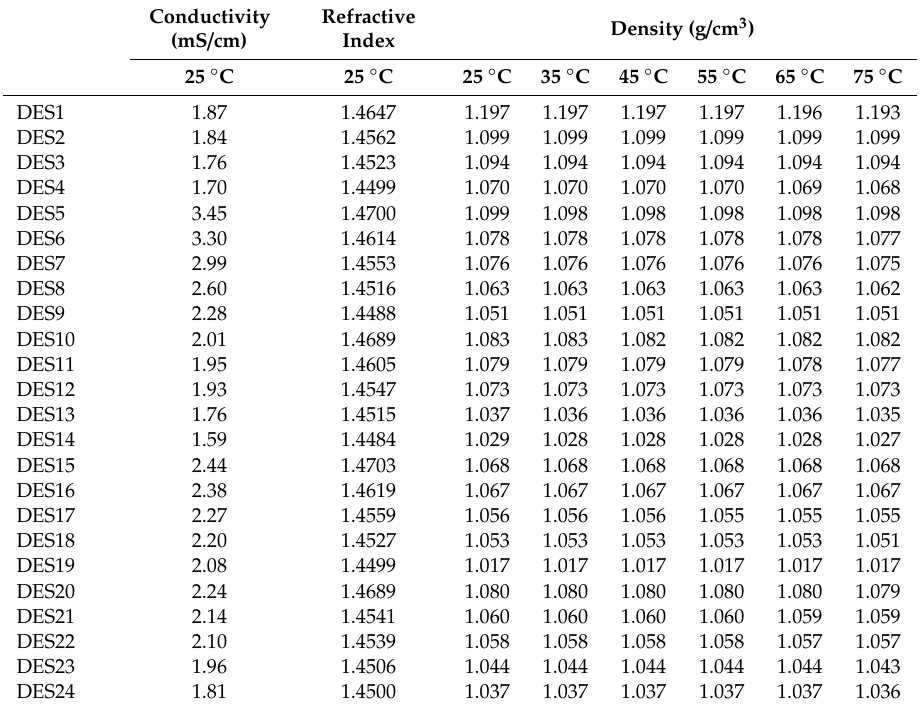
Table 3. Characterization of di ff erent properties of DES (conductivity, refractive index, and